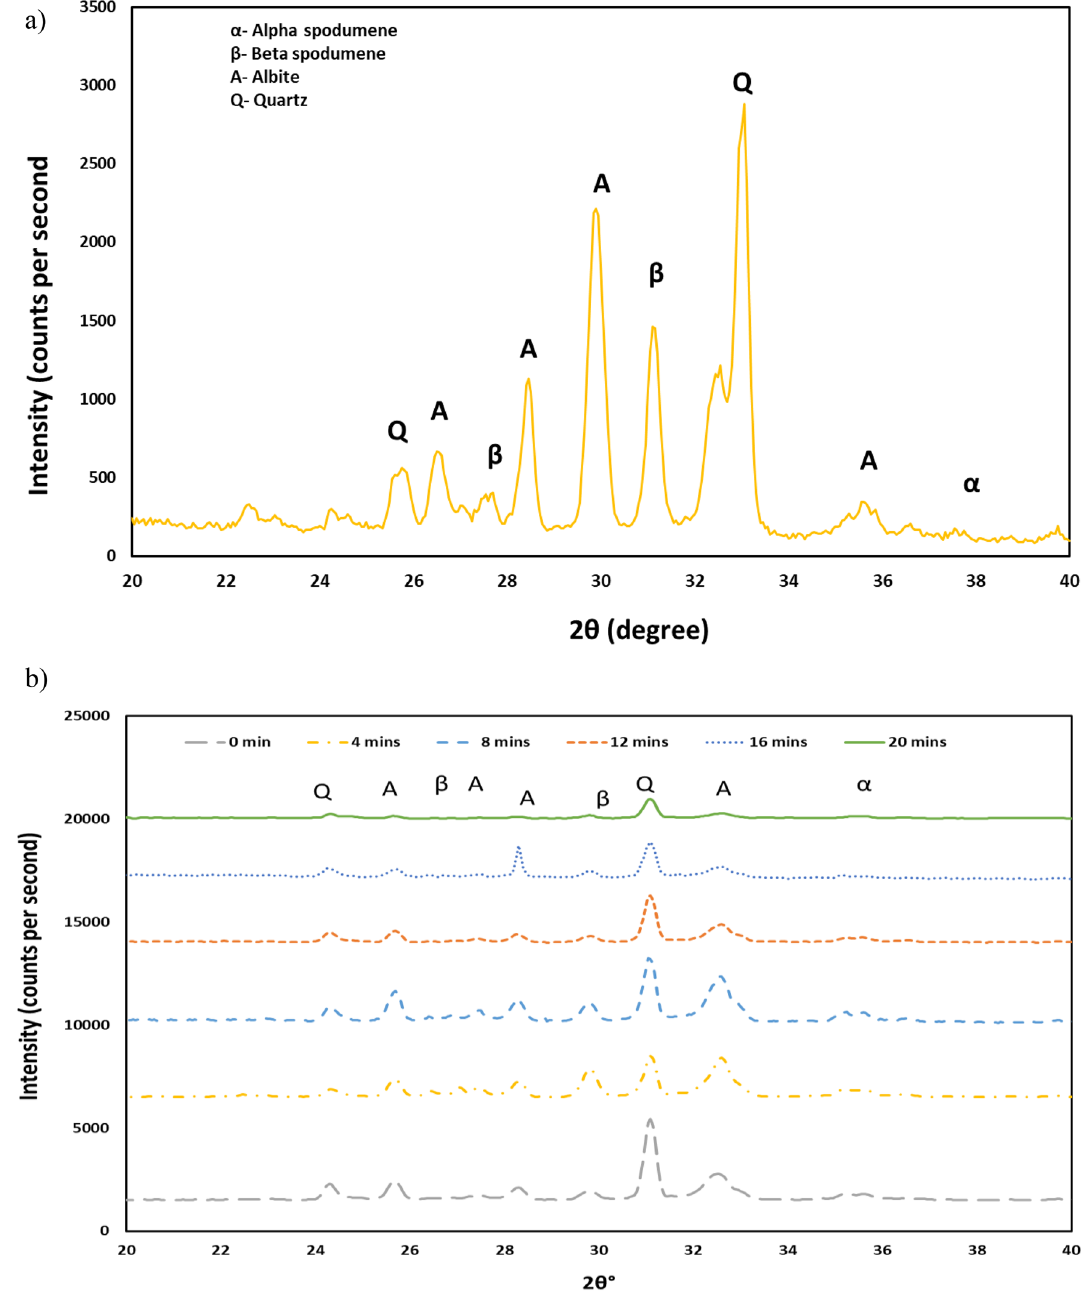
Figure 5. XRD results for samples collected after ( a ) the open-circuit grinding and ( b ) the closed-circuit